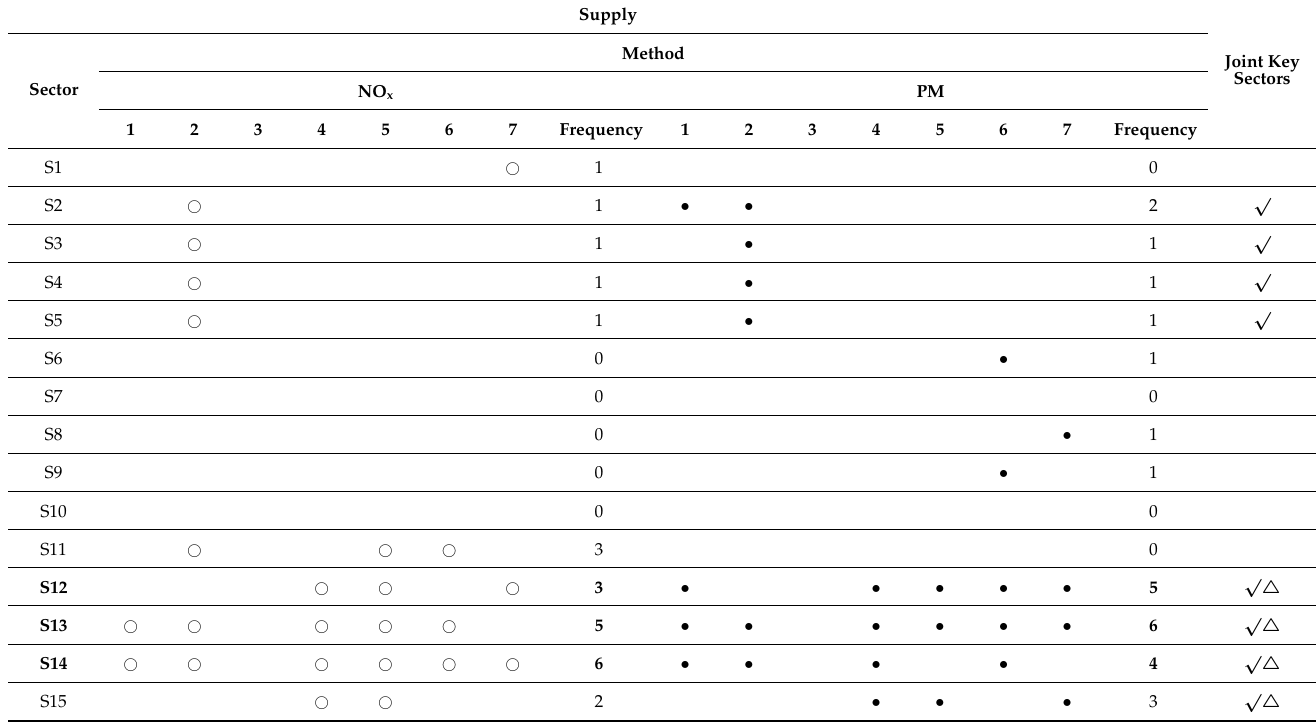
Table 10. The key supply-side sectors of NO x and PM